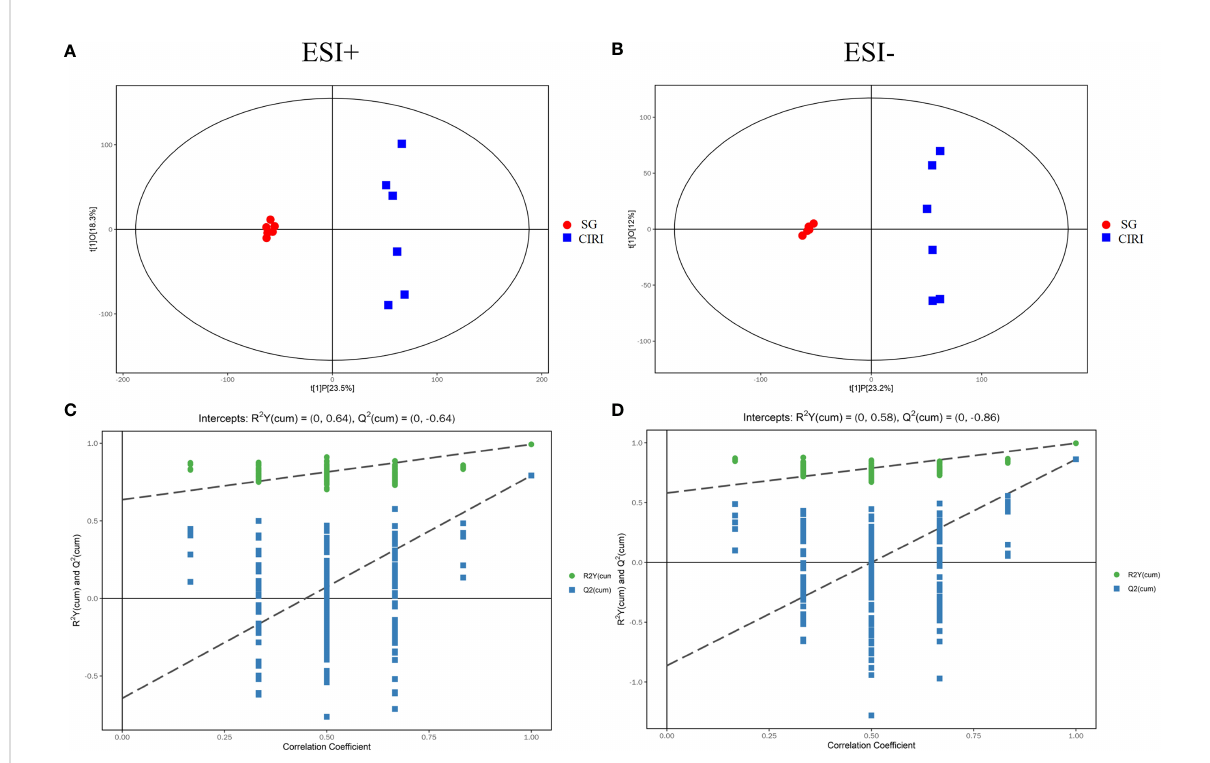
FIGURE 9 The OPLS-DA score plot (A) and OPLS-DA permutation plot (C) in positive mode. The OPLS-DA score plot (B) and OPLS-DA permutation plot (D) in negative